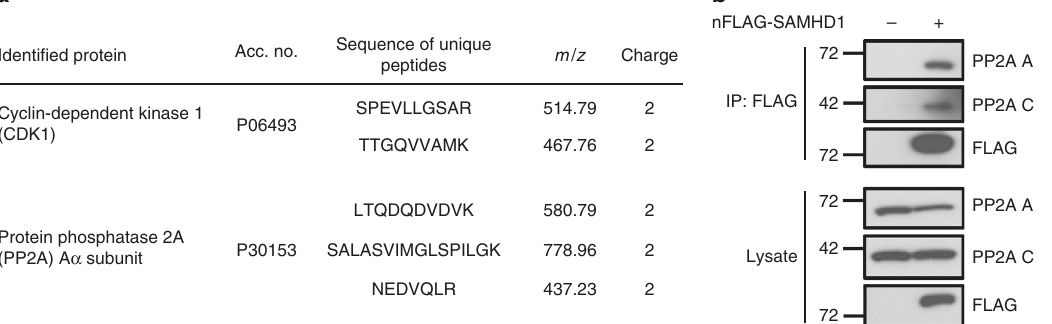
binding to PP2A A and C subunits only to a minor extent (Supplementary Fig. 2e), suggesting that residues responsible for PP2A binding might be accessible in all structural states of SAMHD1.